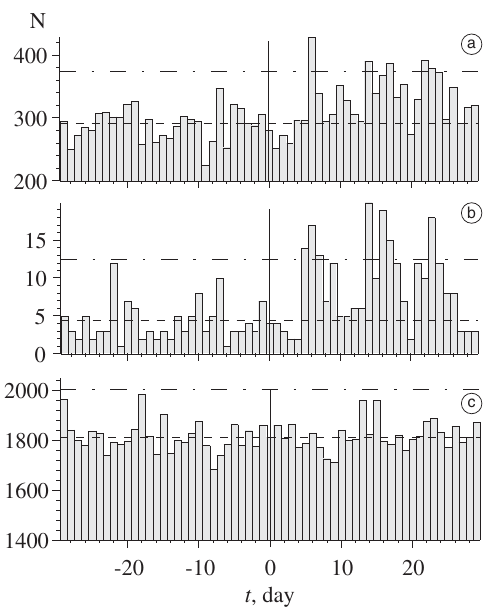
Fig. 13a-c. Daily number of earthquakes in the Garm region of Tadjikistan before ( t < 0) and after ( t > 0) 34 MHD-generator runs on the Garm test site plotted against time for the entire area (a) and for upper 5- km layer of the Tadjik Depression (b), daily number of earthquakes in the same area of Tadjikistan before ( t < 0) and after ( t > 0) 276 local chemical explosions of 400 kg explosive (c). The dashed lines indicate a mean background level (lower lines) and 99% confi- dence interval (upper